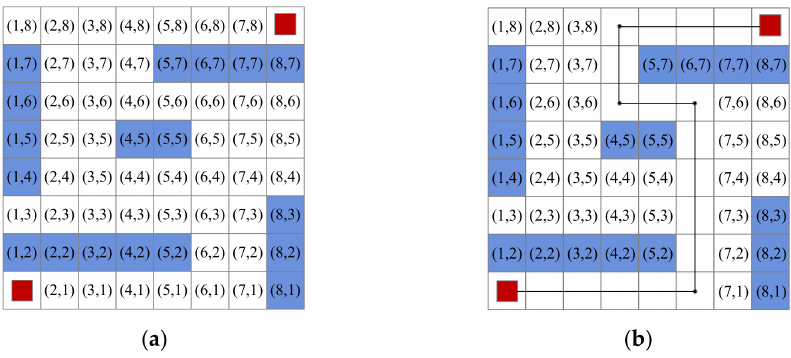
Figure 3. Environment representation. ( a ) XY positions; ( b ) an example of